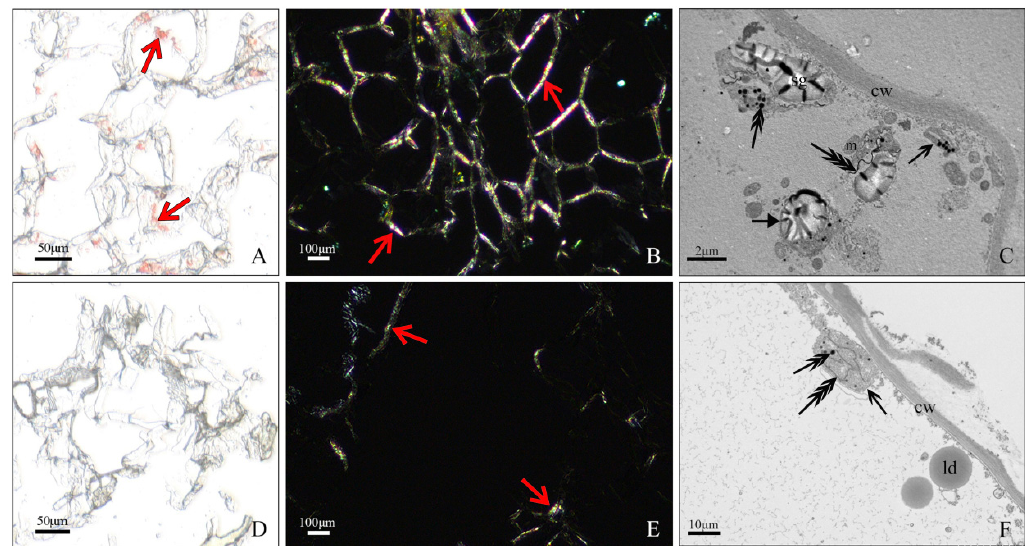
Figure 3. Callus tissues under the slide scanner ( A , D ) and polarization microscope ( B , E ), and ultrastructure of cells from wt callus ( C ) and ym callus ( F ). Tissues from wt were filled with orange crystals (( A , B ), red, open arrows). In contrast, ym callus was rarely observed crystals (( D , E ), red, open arrows). Globular chromoplasts (black, open arrows) were observed in the cells of wt and ym , but amylochromoplasts (arrow) were only observed in wt ; many plastoglobuli (double arrow) were detected in wt but very few in ym . Crystal remnants (triple arrow) were present in both wt and ym . cw: cell wall, ld: lipid droplet, m: mitochondria, sg: starch grain.